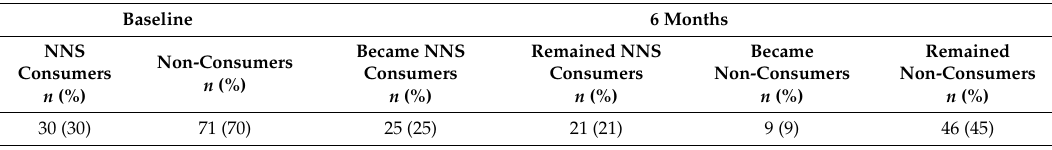
Table 1. Changes in frequencies of non-nutritive sweetener (NNS) consumers and non-consumers in SIPsmartER participants over the 6-month sugar-sweetened beverage reduction intervention.